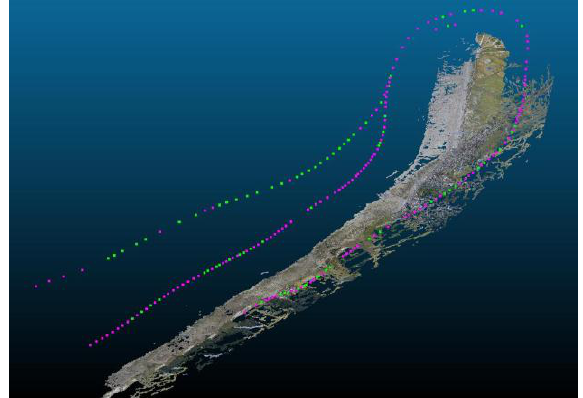
Figure 1 : 3D point cloud and camera positions (green and pink dots) reconstructed with Visual SFM on the area of Ault (Picardy, Northern France). The survey was designed with one pass over land (the right-most dotted line) and two passes offshore to image the cliff face at two different elevations. The site is ca. 7km-long, the sea lies in the upper left part of the